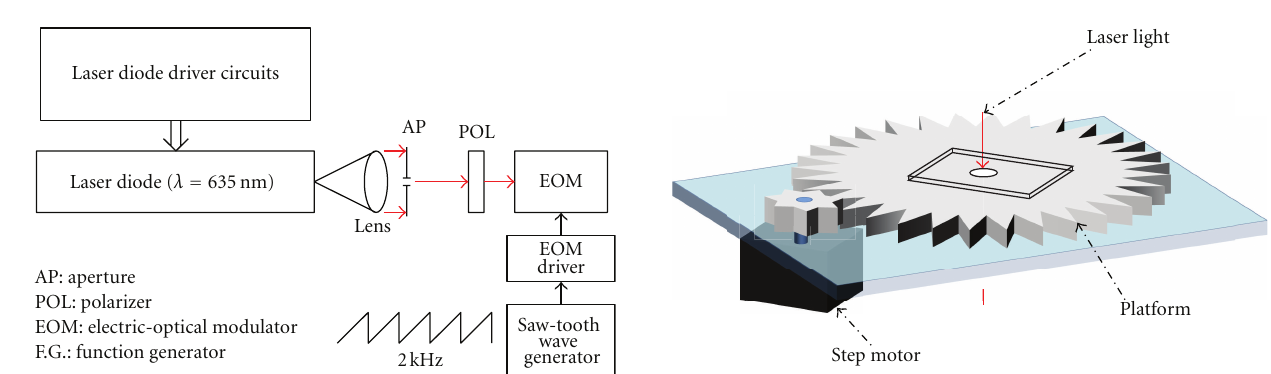
(POL), an aperture (AP), an EOM, an EOM driver, and a